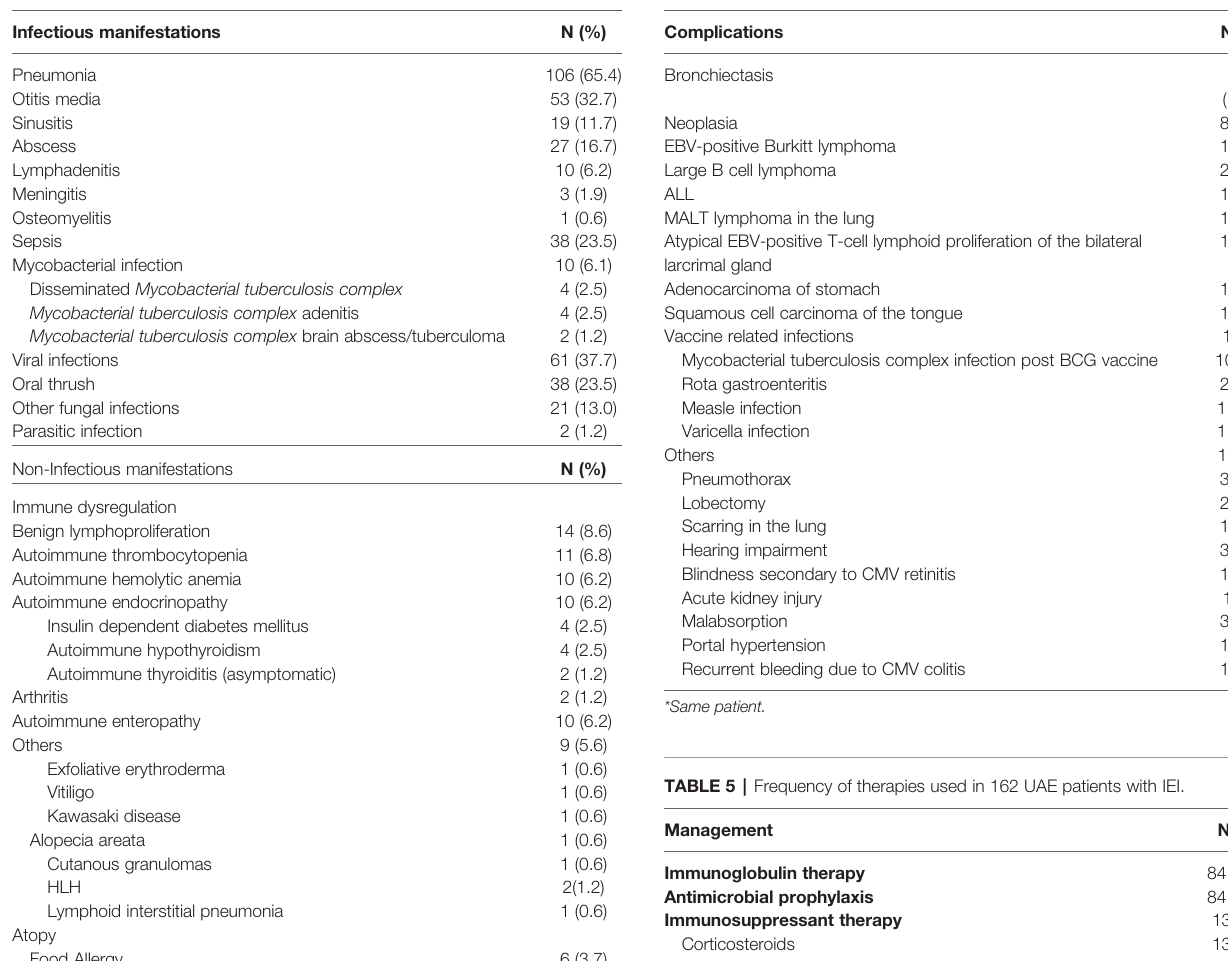
TABLE 3 | Clinical manifestations of 162 UAE patients with IEI. TABLE 4 | Complications of IEI in 162 UAE patients.